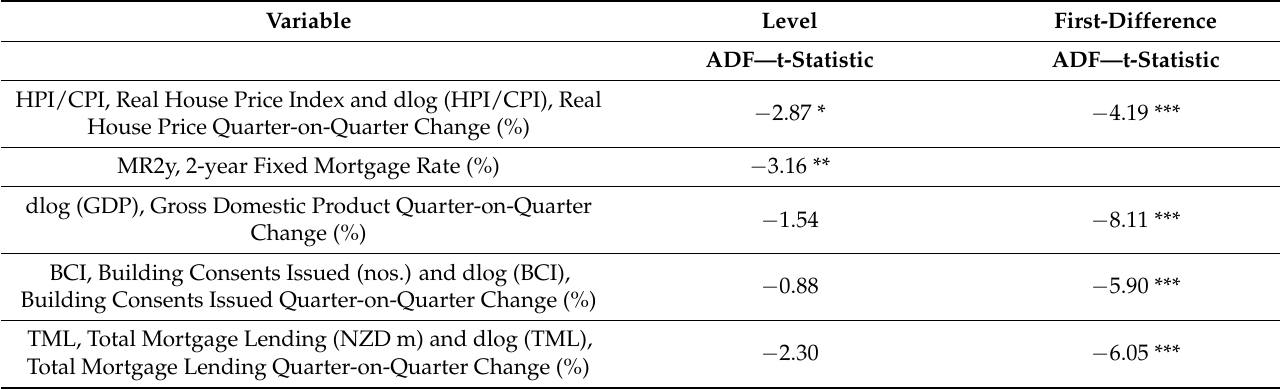
Table 2. Unit root tests of variables, 2016Q2–2022Q3. Notes: figures are statistics, ***, ** and * represent p -value ≤ 0.01, 0.05 and 0.10,